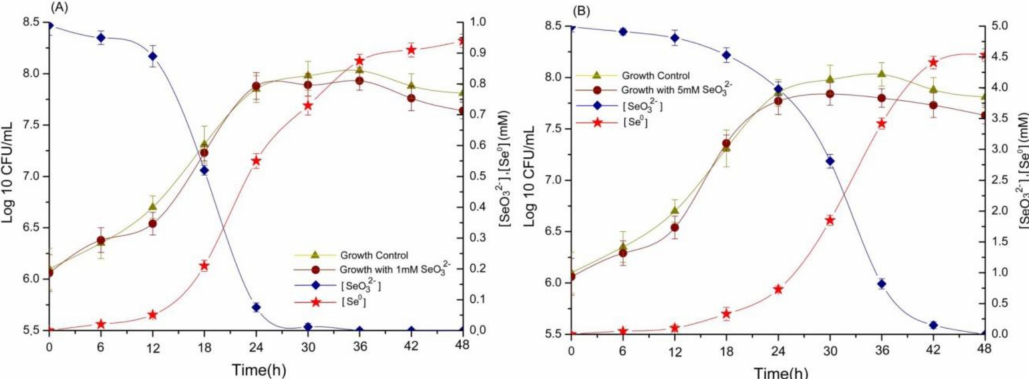
Figure 3. Time courses of bacterial growth, SeO 32 − reduction, and Se 0 formation by the strain A. faecalis Se03 grown in YEP medium supplied with ( A ) 1 mM Na 2 SeO 3 , and ( B ) 5.0 mM Na 2 SeO 3 . Each test was performed in triplicate and error bars represent the standard